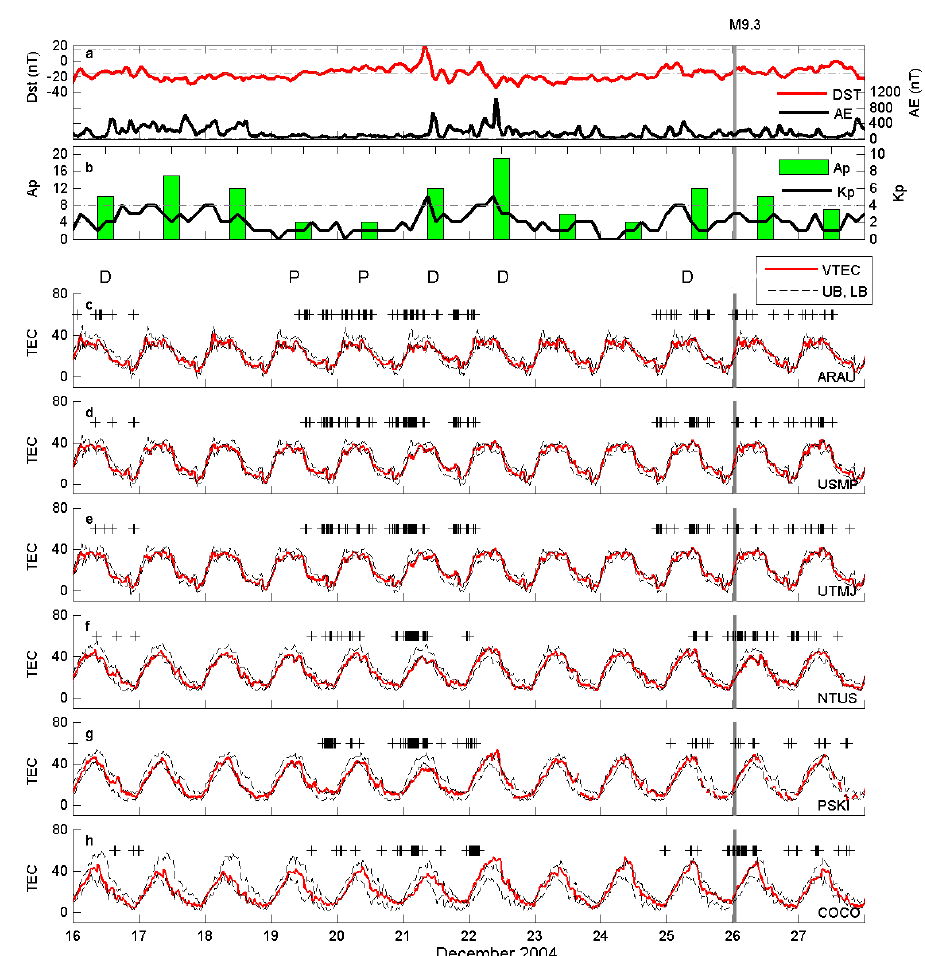
Fig. 2. The geomagnetic indices (a) Dst and AE, (b) Ap and Kp, and the (c) – (h) TEC variations and the associated upper and lower bounds between 16 and 27 December 2004 at 6 GPS stations.